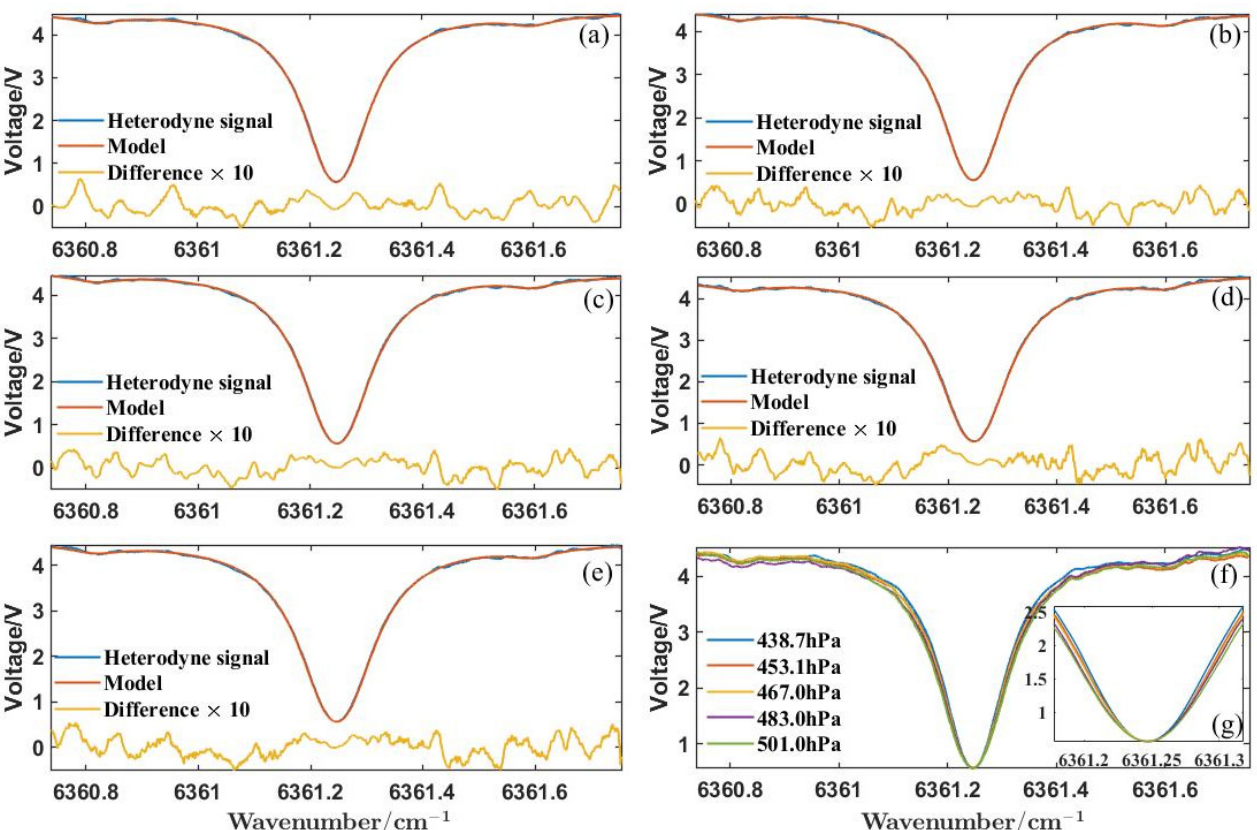
Figure 15. The experimental average heterodyne-signals and the model-fitting results at ( a ) 438.7 hPa, ( b ) 453.1 hPa, ( c ) 467.0 hPa, ( d ) 483.0 hPa, ( e ) 501.0 hPa. ( f ) The differences in the average measured-heterodyne-signals at different pressures. ( g ) The partially enlarged view of ( f ).